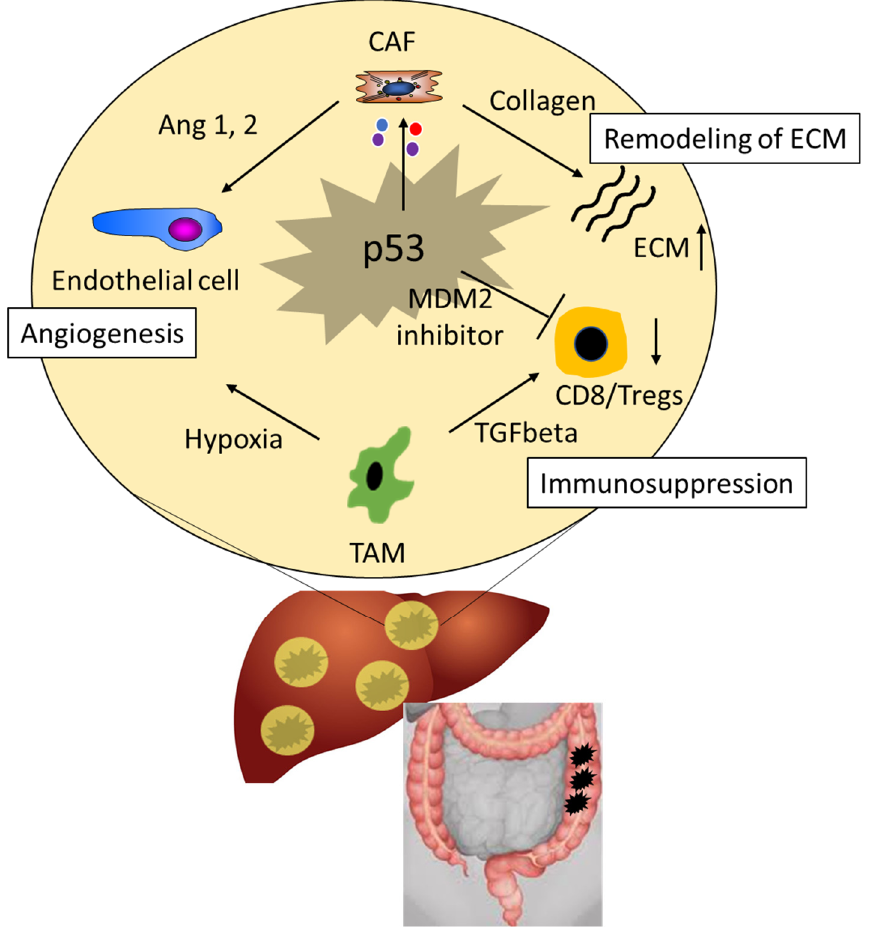
Figure 2. The role of p53 in the tumor microenvironment (TME) of CRC. p53 in tumor cells and surrounding (non-)stromal cells contributes to immune surveillance, angiogenesis and remodeling of extra-cellular matrix (ECM) in CRC. Ang 1, 2, Angiopoietin 1, 2; CAFs, cancer-associated fibroblasts; ECM, extra-cellular matrix; MDM2, E3 ubiquitin-protein ligase Mdm2; TAMs, tumor-associated macrophages; TGF ‐ ß, transforming growth factor beta; Tregs, regulatory T cells.